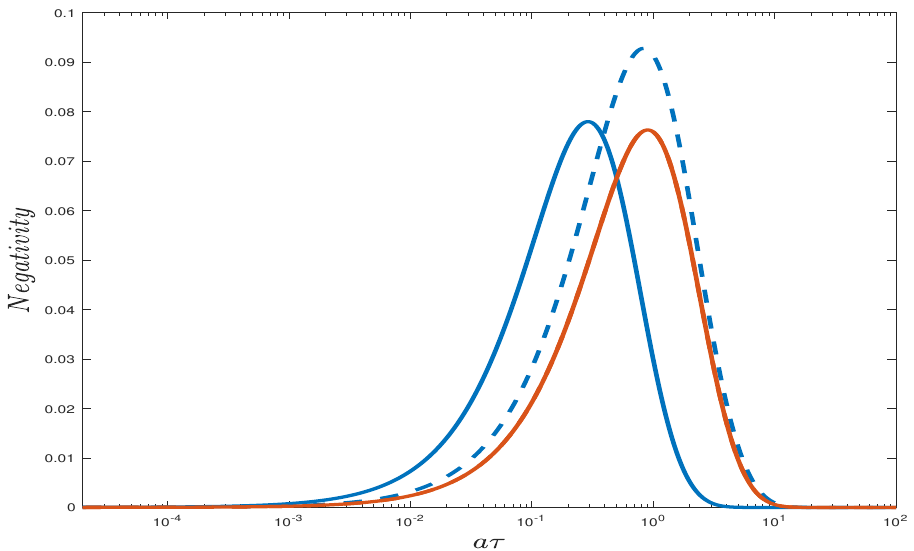
Figure 13 . Entanglement evolutionary process over time for massive field. Blue and red lines stand for D = 3 and D = 4 , respectively. Solid and dashed lines stand for the cases of massless and massive field,